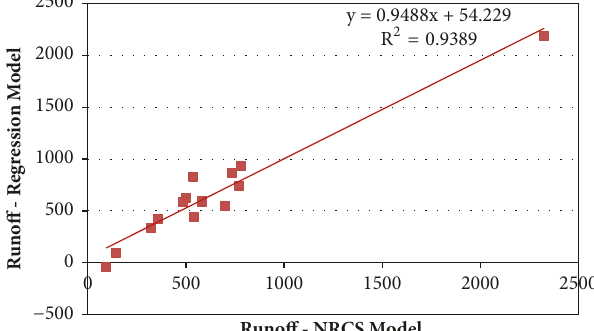
Figure 8: Comparison of annual runoff from NRCS model and regression model.